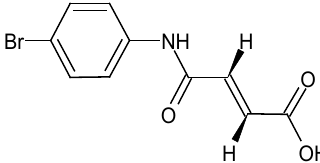
Figure 2. Structure of the 4-bromomaleanilic acid.